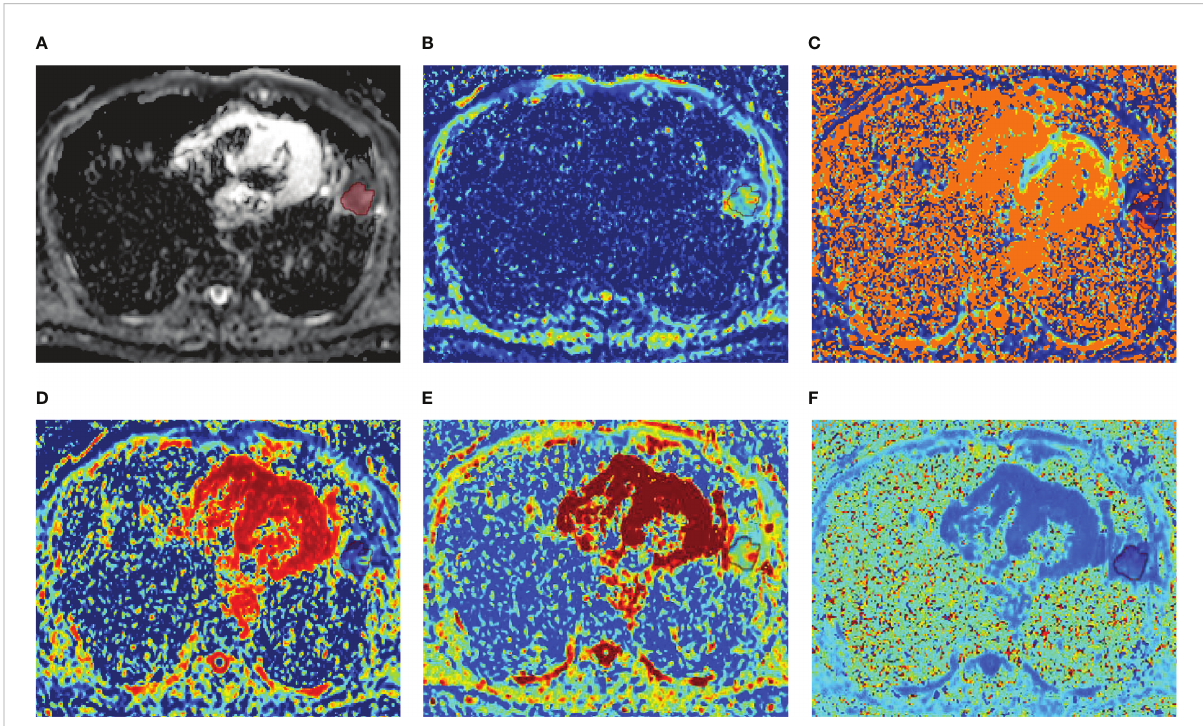
FIGURE 2 A 52-year-old male diagnosed with lung abscess of the left lower lobe. (A) ADC map; (B) D map; (C) D* map; (D) f map (E) Dapp map; (F) Kapp map.